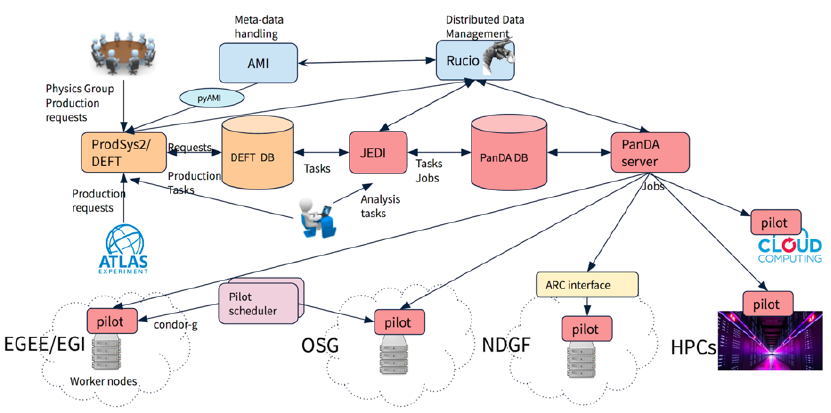
Figure 1: The components of ATLAS distributed computing software: production management (am- ber elements), metadata and distributed data management (blue elements), workload management (red